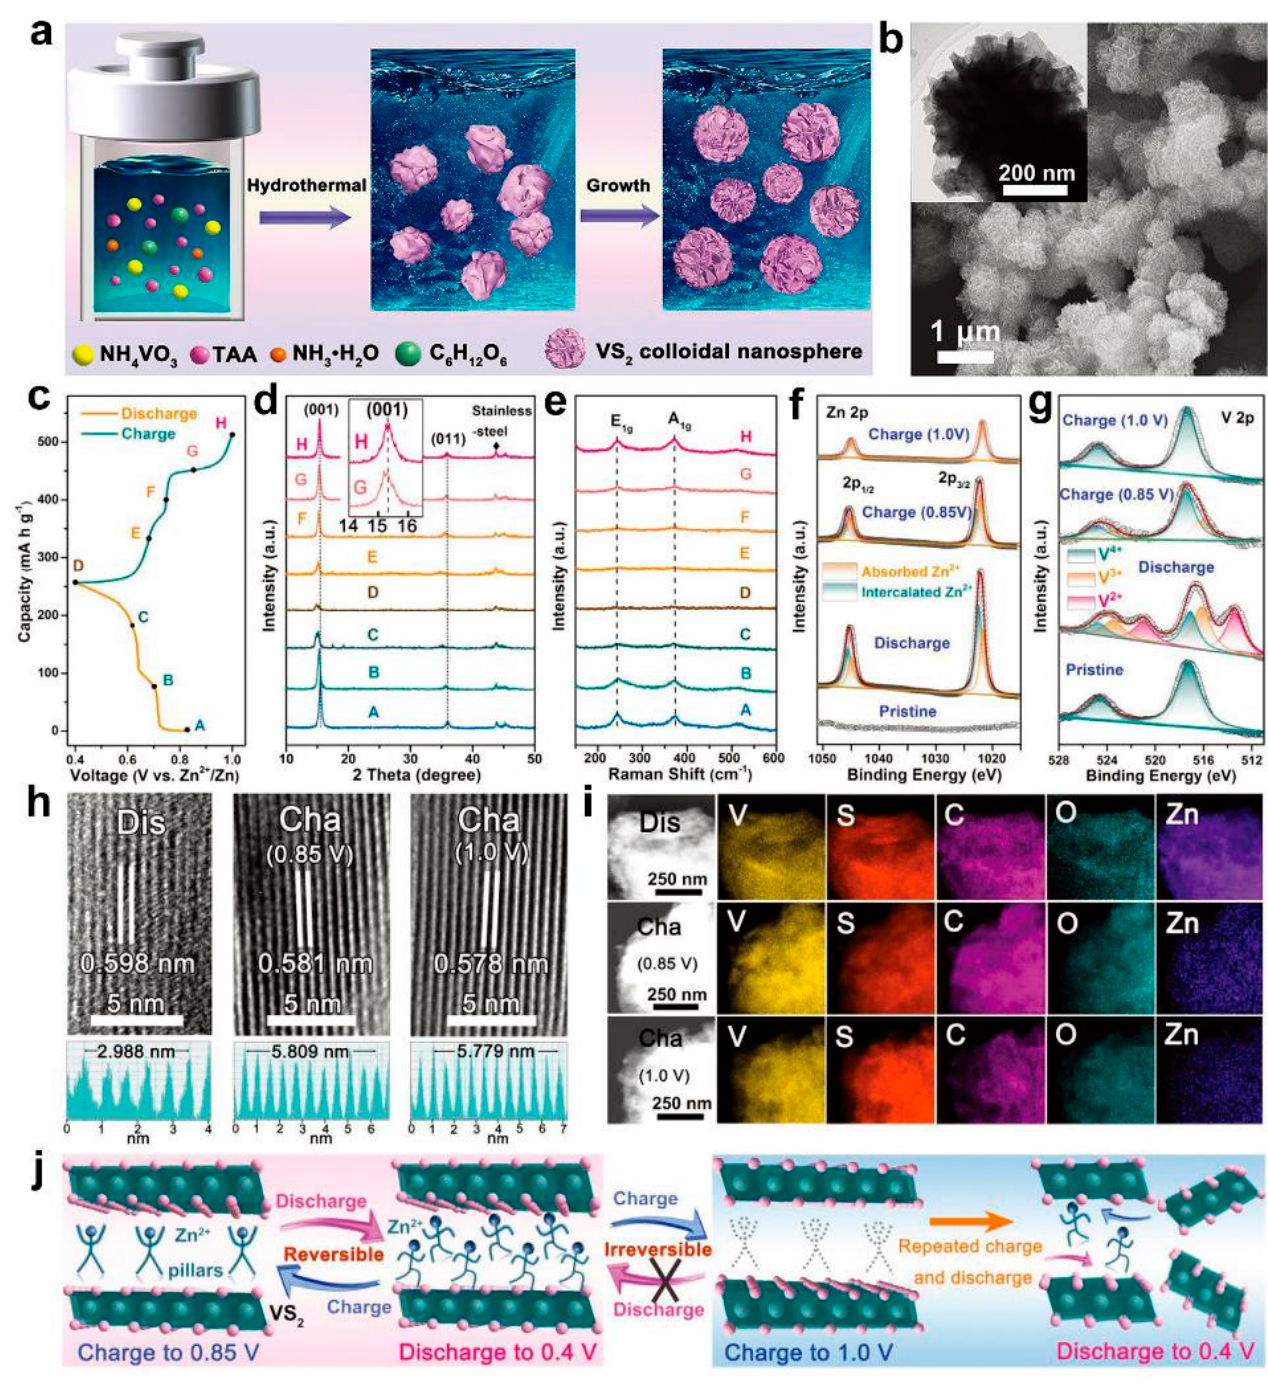
Figure 3. ( a ) Diagrammatic representation of the 1T-VS 2 growth process [49]. ( b ) The SEM and TEM images of 1T-VS 2 [49]. ( c ) 1T-VS 2 in the voltage range 0.4–1.0 V, GCD at different potential points in the first cycle (The coloured letters A–H in subfigures ( c – e ) indicate the different potential points) [49]. Ex-situ ( d ) XRD patterns of 1T-VS 2 , ( e ) Raman spectra of 1T-VS 2 , ( f ) Zn 2p, and ( g ) V 2p XPS spectra of 1T-VS 2 . ( h ) HRTEM images and ( i ) STEM element mapping images of the 1T-VS 2 [49]. ( j ) Diagram of the zinc-ion storage mechanism of 1T-VS 2 at different cut-off voltages (0.85 and 1.0 V) [49].